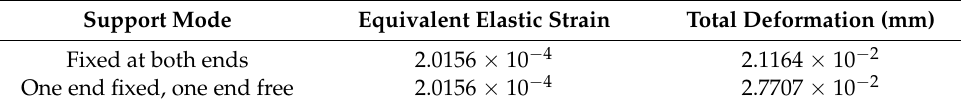
Table 5. Equivalent elastic strain and total deformation data of lead screw.